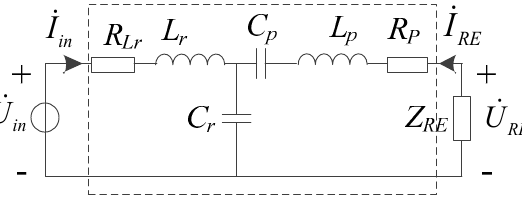
Figure 7. Two port network of LCC compensation.